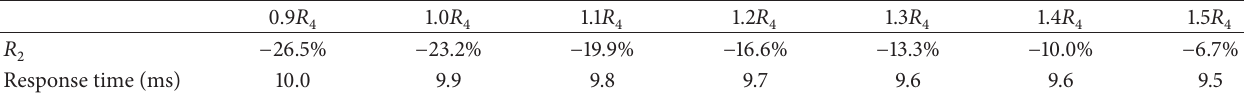
Table 7: Changing rate of 𝑅 2 and response time due to change in 𝑅 4